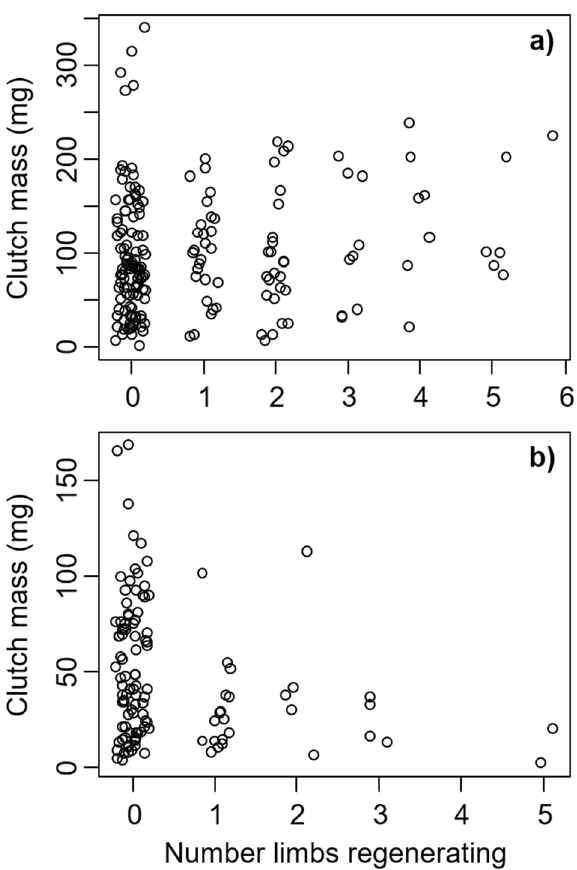
Figure 3. Clutch mass of Hemigrapsus sanguineus sampled in 2020 as a function of the number of missing limbs that are regenerating. Part ( a ) shows crabs > 20 mm CW and part ( b ) shows crabs < 20 mm